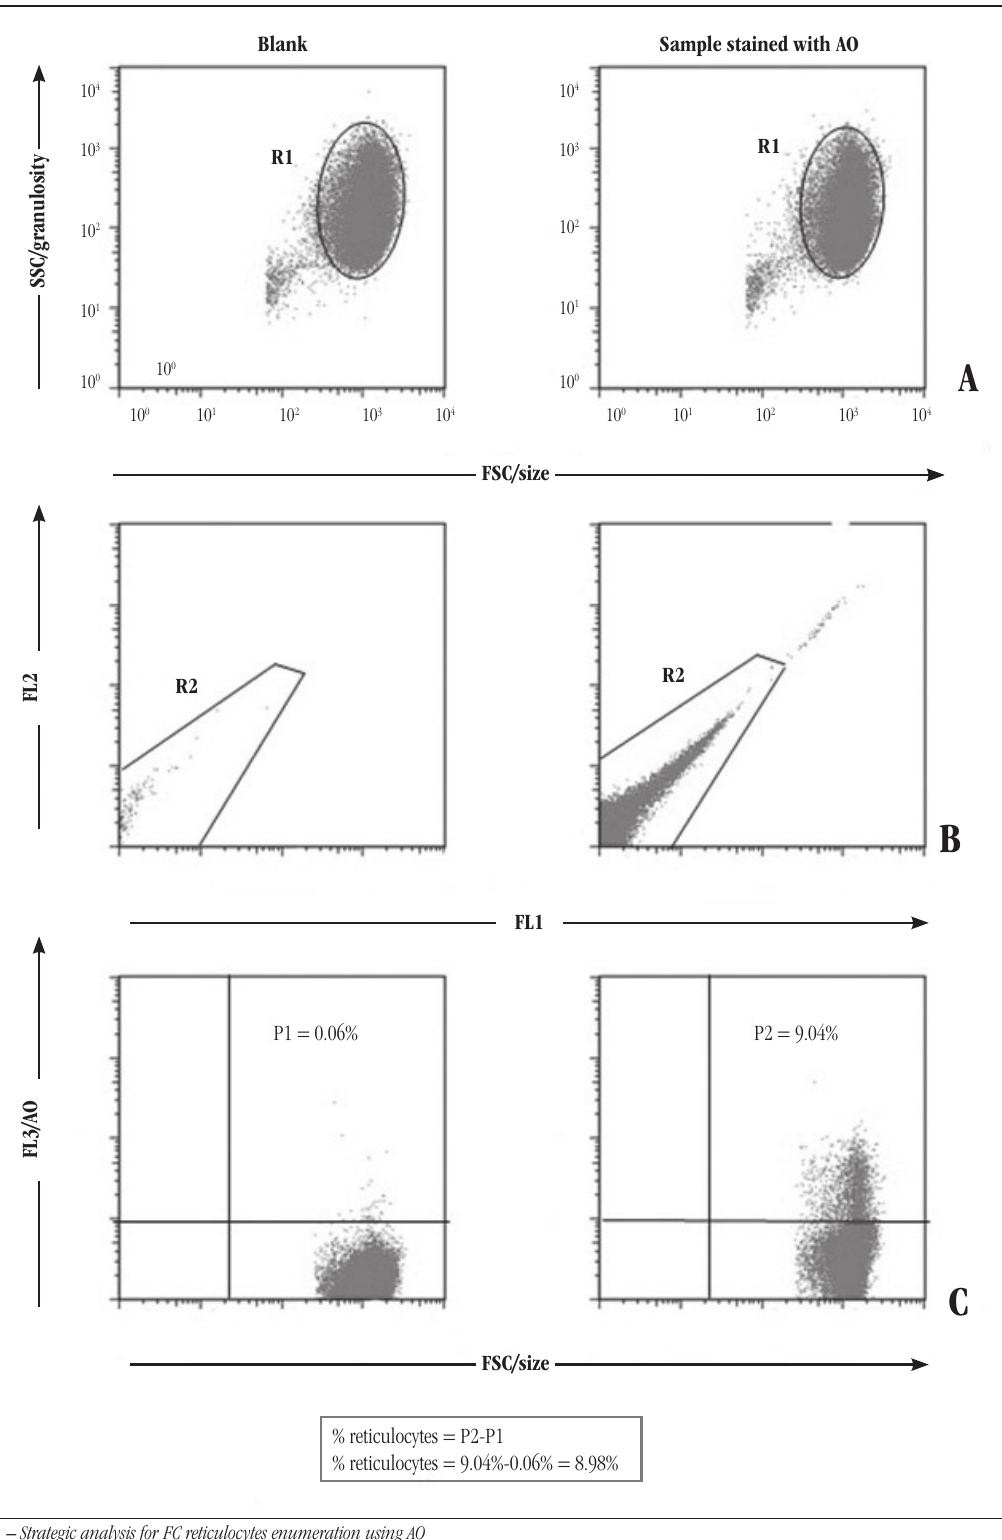
figurE 2 – Strategic analysis for FC reticulocytes enumeration using AO (A) Selection of the population of interest based on morphometric aspects (R1); (B) selection of homogeneous population (R2), excluding possible interfering; (C) percentage quantification of positive cells in right upper quadrant for the selected cells population from the proposed gate (R1 e R2). FC: flow cytometry; AO: acridine orange; SSC: side scatter channel; FSC: forward scatter